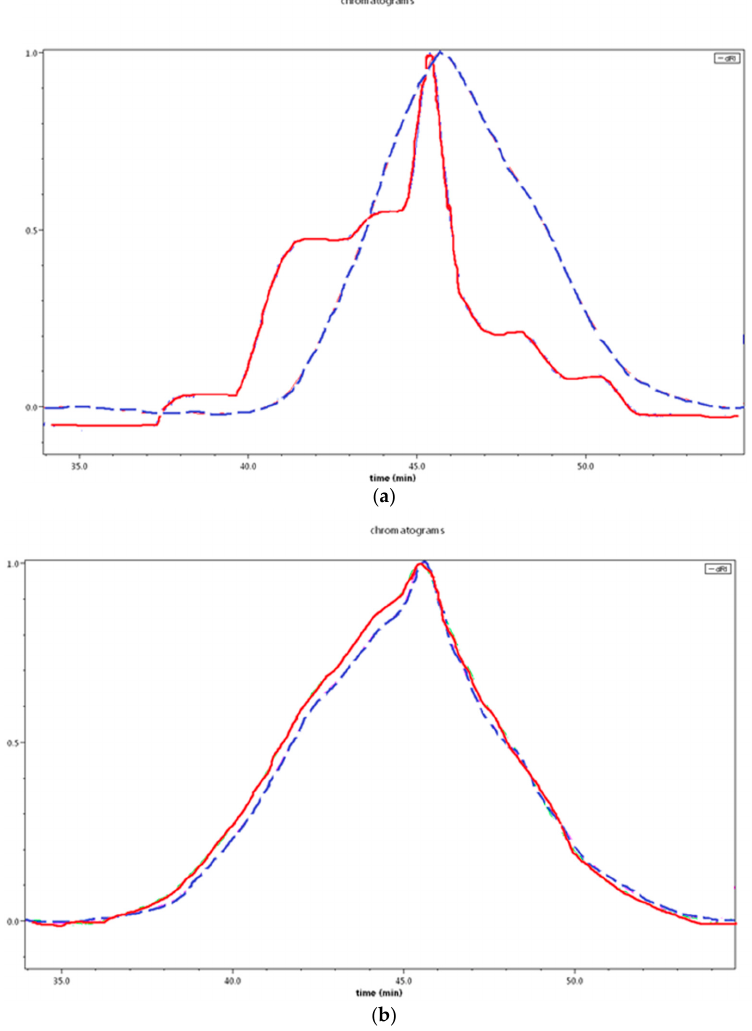
Figure 6. High resolution SEC chromatograms of films ( a ) PBS-DLS 70-30 and ( b ) PBS-DLS 50:50, before (solid line, red) and after (dashed line, blue) degradation (24 days).